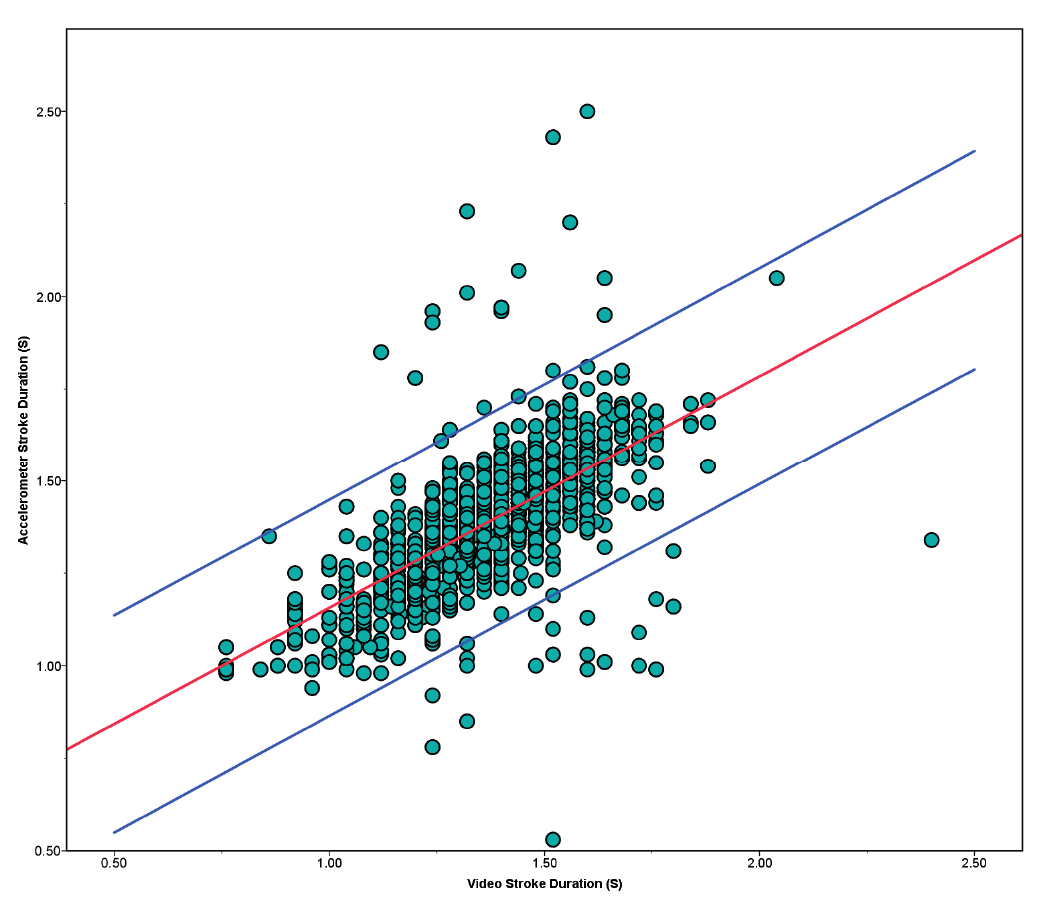
Figure 11. Stroke Duration Calculation. Black line shows correlation, red lines show 95%